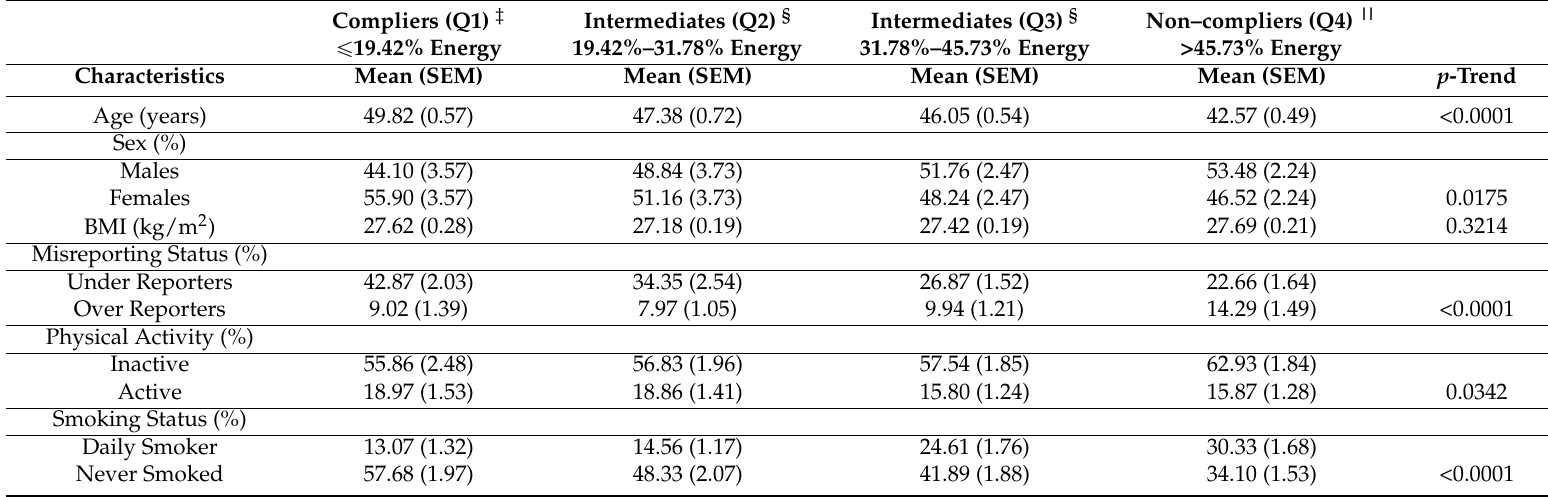
Table 3. Weighted analysis of characteristics of compliers, intermediates, and non-compliers based on the percentage of energy from Tier 4 foods and “other” foods/beverages among Canadian adults ( ě 19 years) * ,†